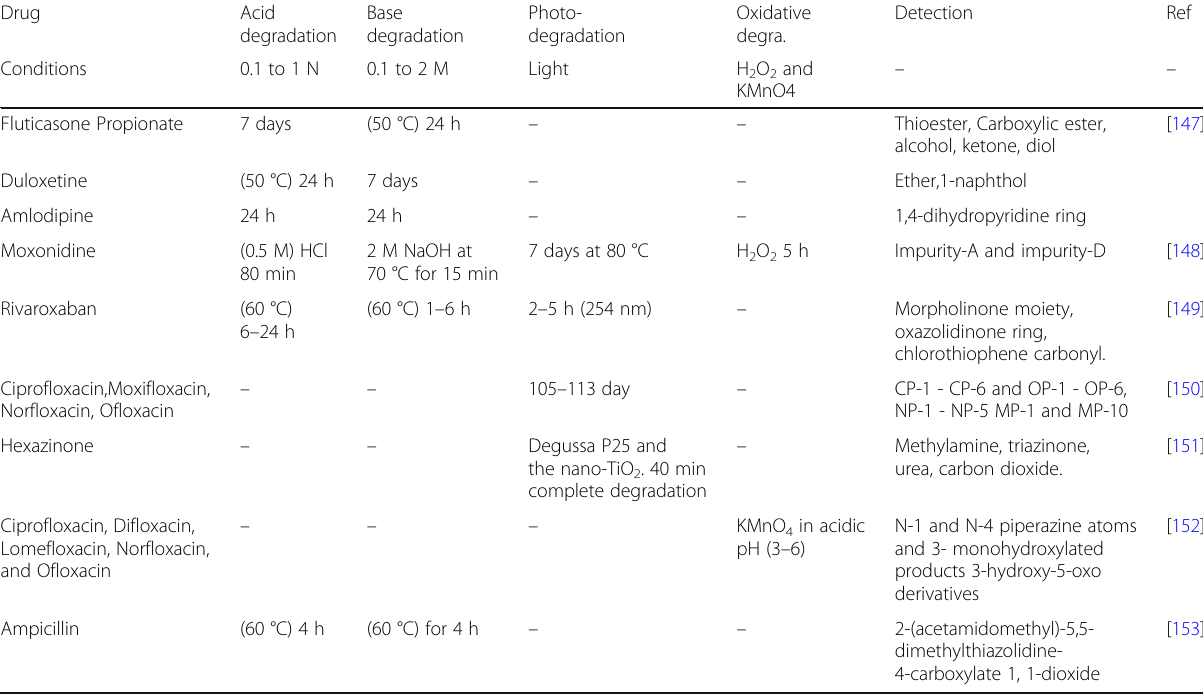
Table 4 Stability-indicating method